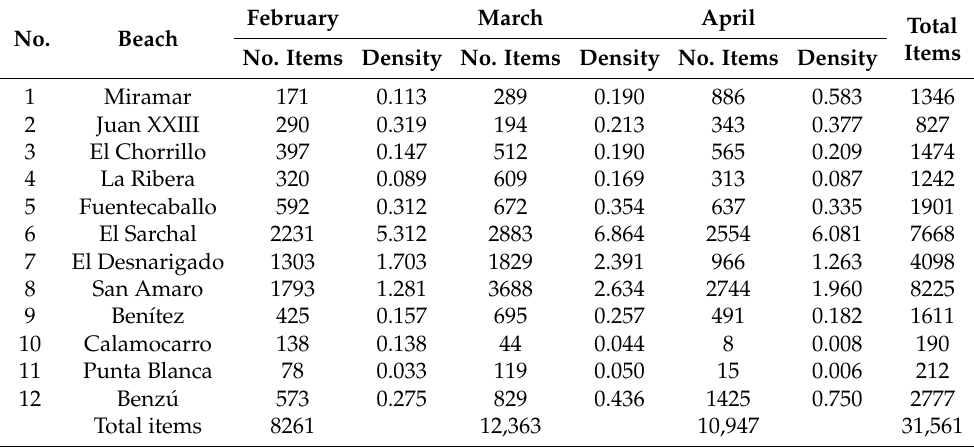
Table 3. Litter abundance at investigated beaches (items per 100 m beach sectors and items m − 2 ). February No. Beach